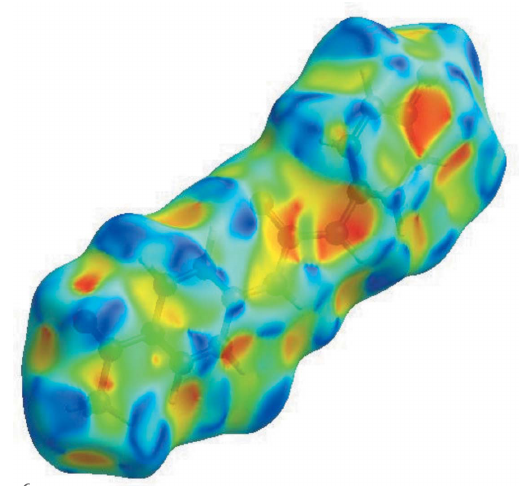
Figure 6 Hirshfeld surface of the title complex plotted over